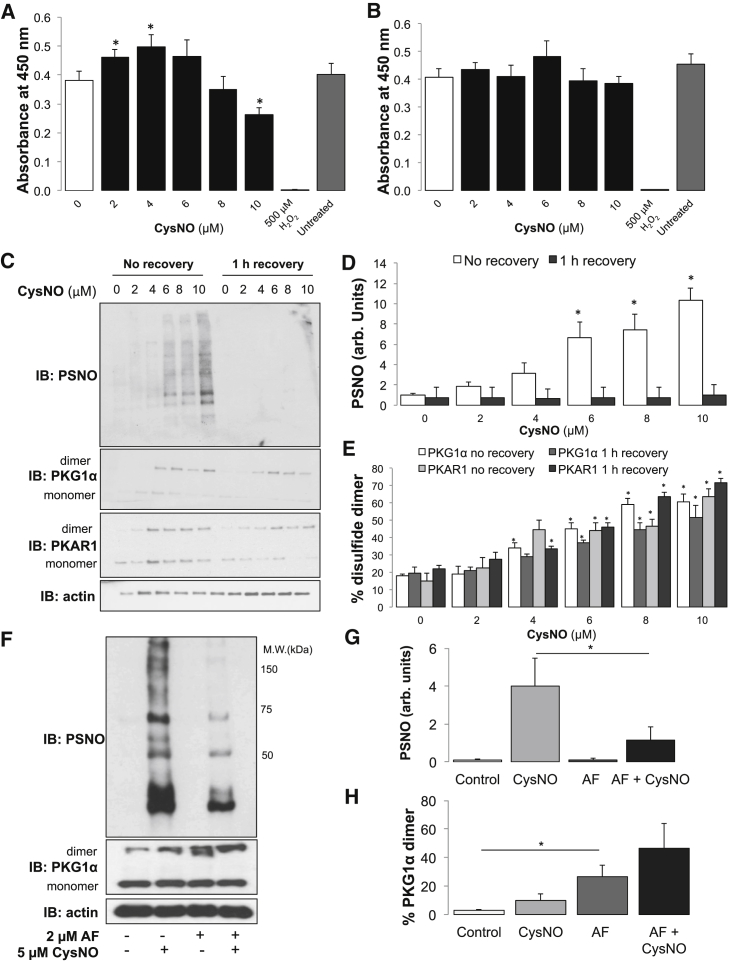
The NO Donor Reduces SMCs’ Capacity to Recycle Disulfides(A) The activity of NADPH-dependent enzymes was measured using the 3-(4,5-dimethylthiazol-2-yl)-5-(3-carboxymethoxyphenyl)-2-(4-sulfophenyl)-2H-tetrazolium (MTS) assay after SMCs were exposed to CysNO. Enzymes were significantly inhibited after exposure to 10 μM CysNO for 30 min.(B) When SMCs were allowed to recover for 1 hr after exposure to CysNO, changes in activity were abolished.(C) PSNOs were detected using the biotin switch method in SMCs that had no recovery or 1 hr recovery after CysNO treatment. SMCs that had no recovery period showed a dose-dependent increase in PSNO along with a concurrent increase in PKAR1 and PKG1α disulfide dimers. After a recovery period of 1 hr, there was no observable increase in PSNO, but a dose-dependent increase in PKAR1 and PKG1α disulfide dimers was apparent.(D) A recovery period of 1 hr abolished the detection of PSNO following treatment with CysNO.(E) A significant increases in PKAR1 and PKG1α disulfide dimers were observed in both SMCs with no recovery and after 1 hr recovery.(F) SMCs were treated with AF for 1 hr prior to exposure to CysNO, and then PSNO, PKG1α and α-actin were measured.(G) Treatment with AF prior to CysNO exposure significantly decreased observable PSNO.(H) AF treatment induced a significant increase in the PKG1α disulfide dimer that was exacerbated with exposure to CysNO.Data are represented as mean ± SEM; ∗p < 0.05.